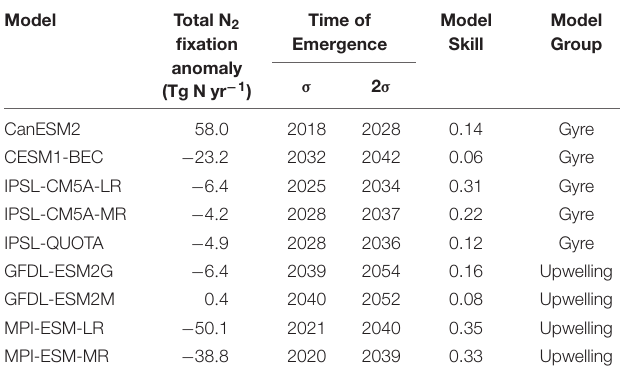
TABLE 1 | Summary of model analysis: Total N 2 fixation anomaly [RCP8.5 (2081:2100) – historical (1986:2005)], time of emergence of global N 2 fixation when the natural variability is calculated using 1 standard deviation ( σ ) and 2 standard deviations (2 σ ) of the control simulation, model skill represents